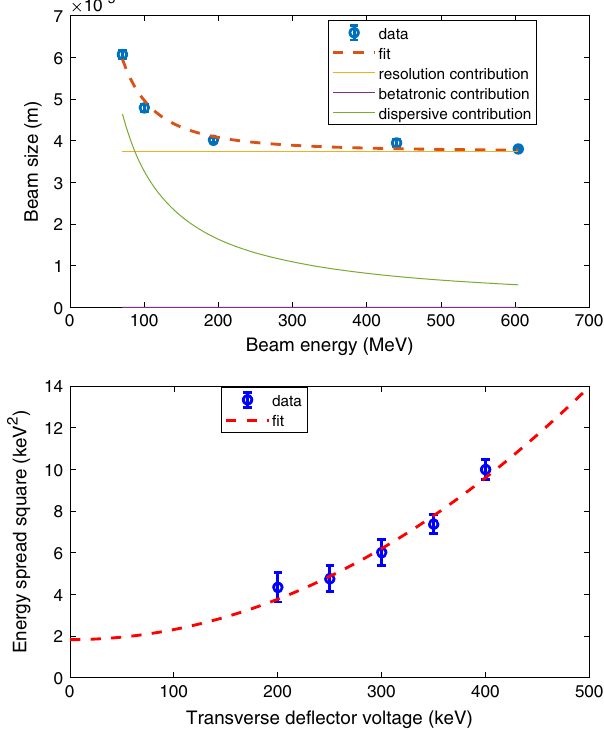
FIG. 2. High-resolution energy spread measurement. Top: energy scan for V ¼ 0 . 25 MV to determine the energy spread and the measurement resolution at this voltage. Bottom: mea- sured energy spread as a function of the TD voltage to reconstruct the true energy spread. See text for more